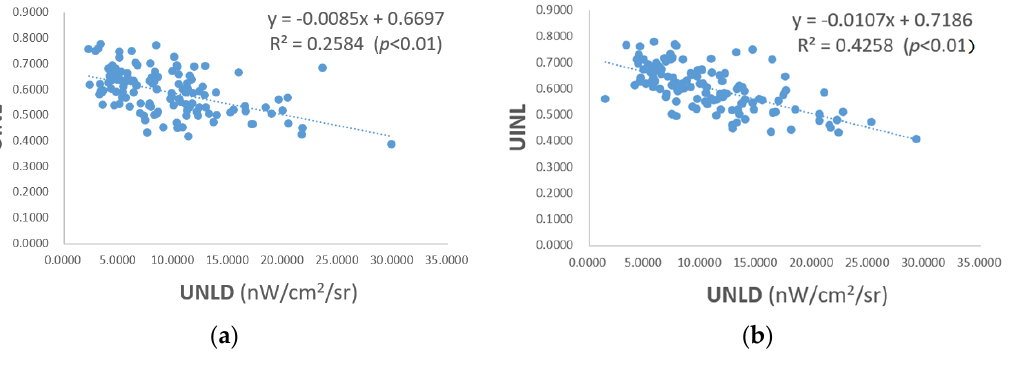
Figure 15. The OLS regression for UNLD and UINL: ( a ) 2012; ( b ) 2019. Table 6. GWR and OLS regression results of UNLD and UINL for 2012. Variable